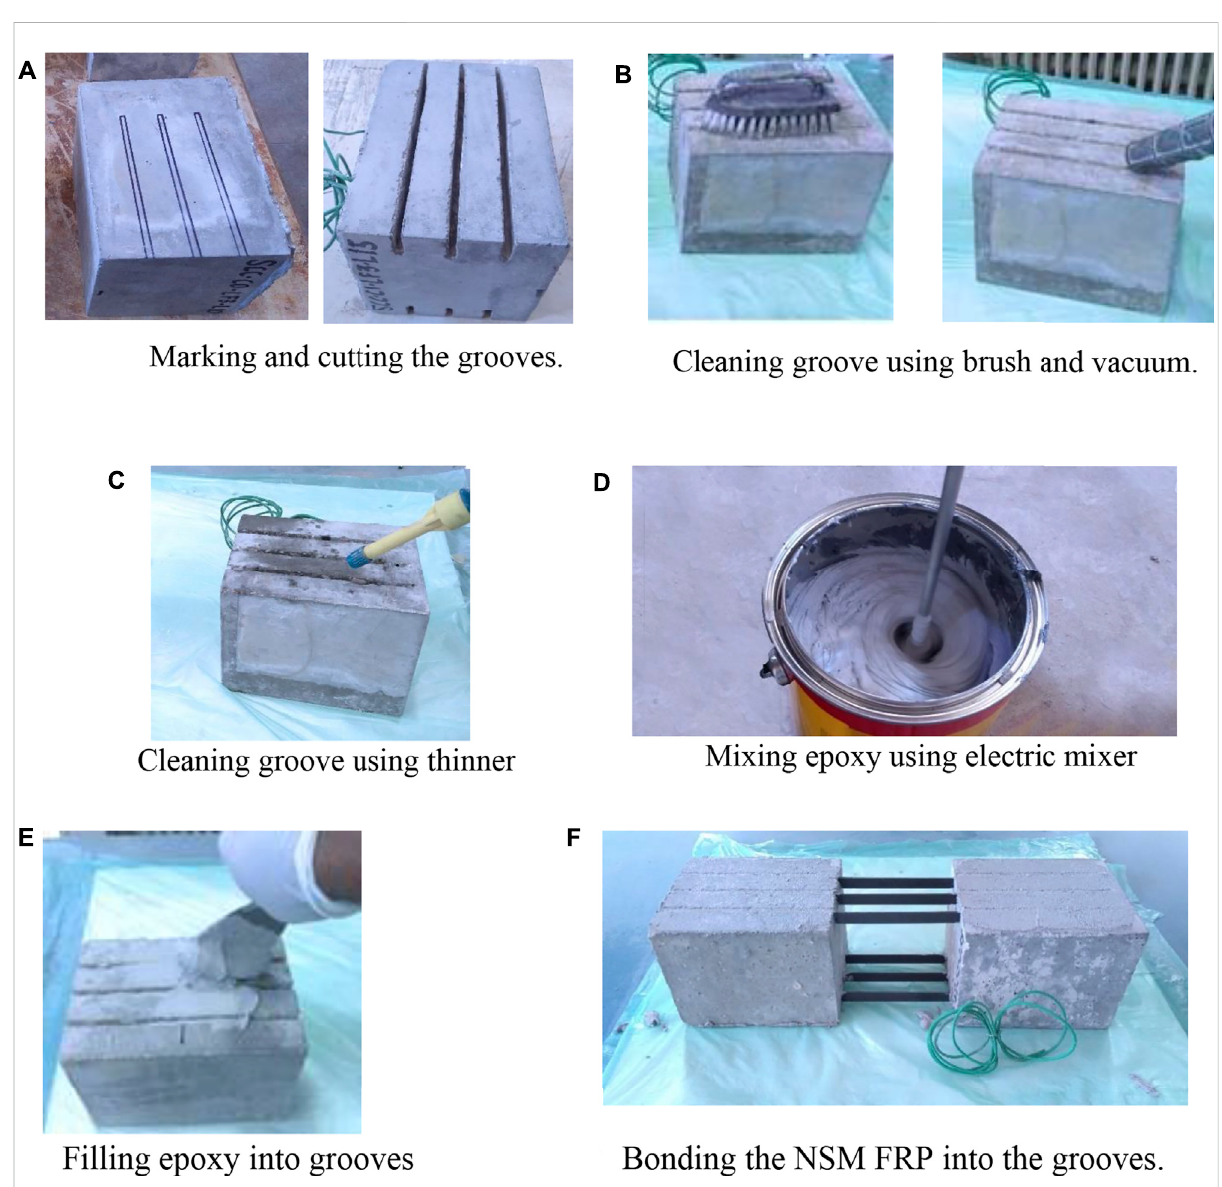
FIGURE 3 Installation of the FRP strips. (A) Marking and cutting the grooves. (B) Cleaning groove using brush and vacuum. (C) Cleaning groove using thinner. (D) Mixing epoxy using electric mixer. (E) Filling epoxy into grooves. (F) Bonding the NSM FRP into the